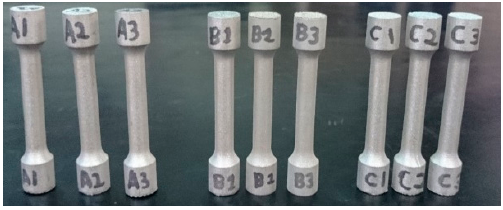
Figure 2. Uniform specimen sets.